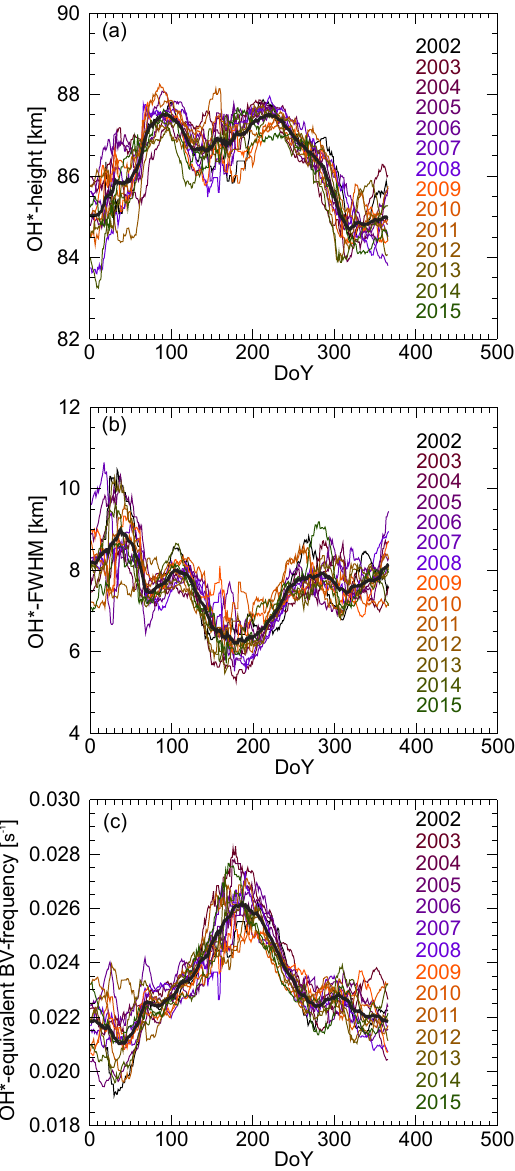
Figure 2. OH* height (a) , FWHM (b) , and OH*-equivalent BV fre- quency (c) show characteristic variations during the year (coloured lines: 30-point running means of the daily mean values with mir- rored edge points for the beginning of 2002 and the end of 2015). The values of the individual years deviate most from the mean over all years (black line) during winter and especially at the beginning of the year. This might be due to enhanced atmospheric dynamics which is for example represented by stratospheric warming events and its effects on the